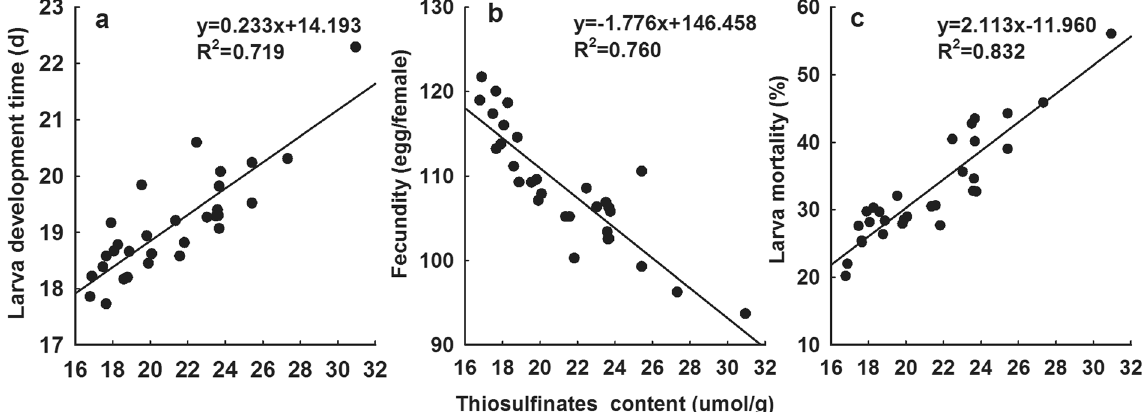
Figure 4. Correlation between thiosulfinates contents and insect-resistance among garlic cultivars. The correlation between thiosulfinates contents and larval development time ( a ), fecundity ( b ) and larval mortality ( c ) of B. odoriphaga reared on 10 garlic cultivars in different growth stages was analyzed by linear-regression analysis.